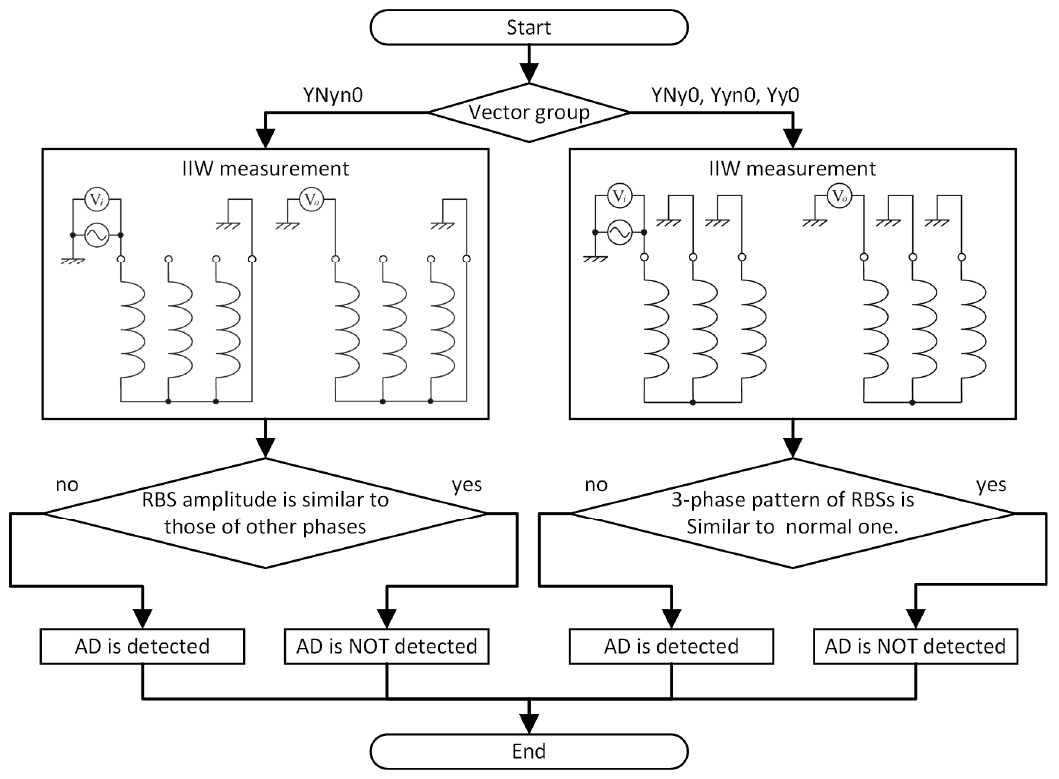
Figure 9. Proposed method of AD detection by FRA without fingerprint data.